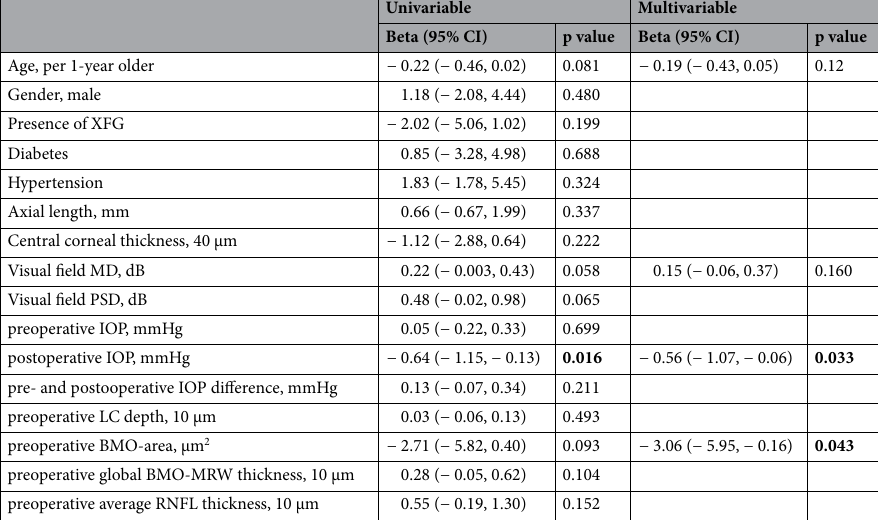
Table 4. Factors associated with increase in the global Bruch’s membrane opening minimum rim width thickness (per 10 µm) after trabeculectomy. XFG exfoliation glaucoma, MD mean deviation, PSD pattern standard deviation, dB decibel, IOP intraocular pressure, LC lamina cribrosa, BMO-MRW Bruch’s membrane opening-minimum rim width, RNFL retinal nerve fiber layer. Beta coefficients were calculated based on the 10 µm increase in the BMO-MRW. Statistically significant p-values are shown in bold.